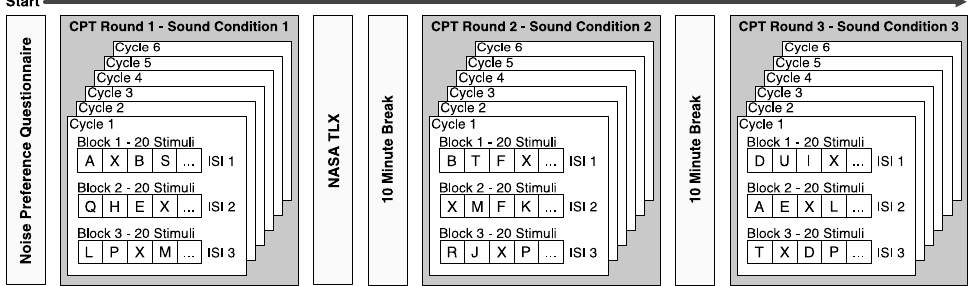
Figure 4. Overall experiment